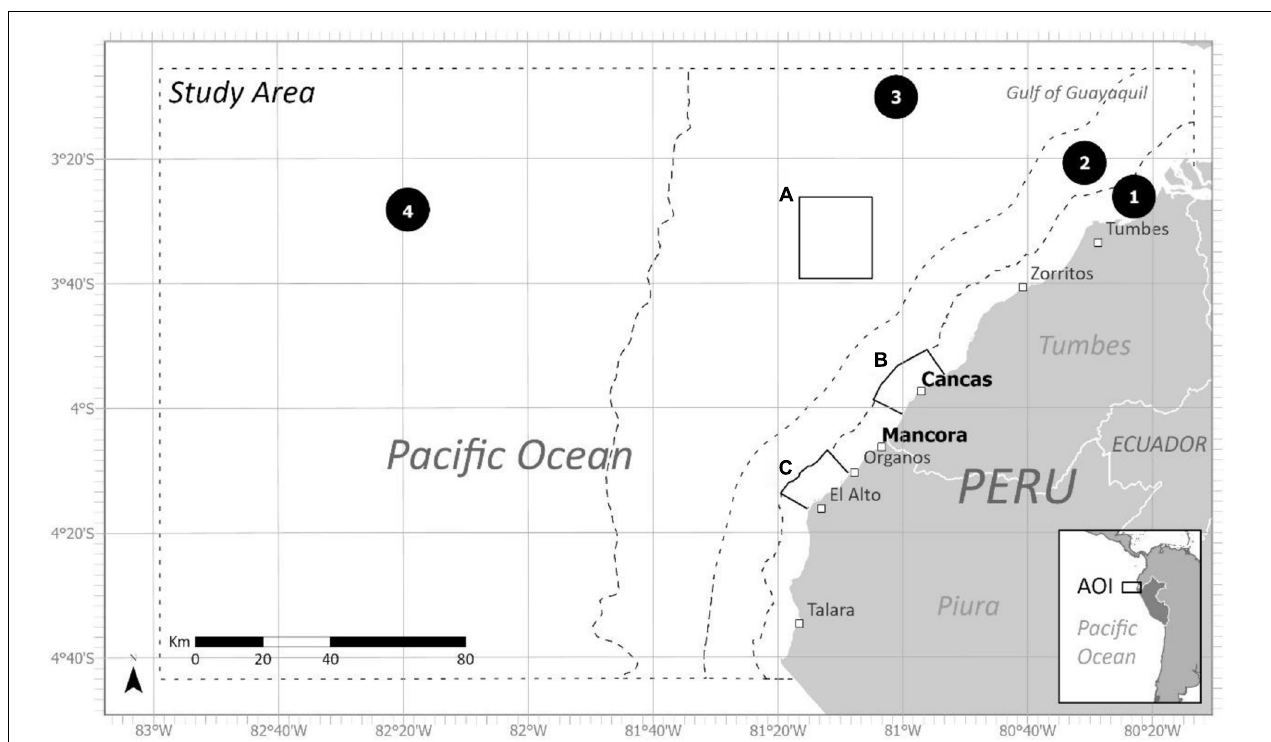
FIGURE 2 | Northern Peruvian coastline and the two fishing ports where interviews were conducted- Mancora and Cancas. Map is divided into study area and seven additional subzones. Zone (1) delineates the 5 nm artisanal fisheries boundary, Zone (2) delineates the 12 nm territorial seas boundary, Zone (3) delineates the cut-off for the bathymetric shelf, and Zone (4) contains the waters beyond the shelf. The second group of subzones were the boundaries of three proposed Marine Protected Areas including (A) Banco de Mancora, (B) Arrecifes de Punta Sal, and (C) Cabo Blanco–El